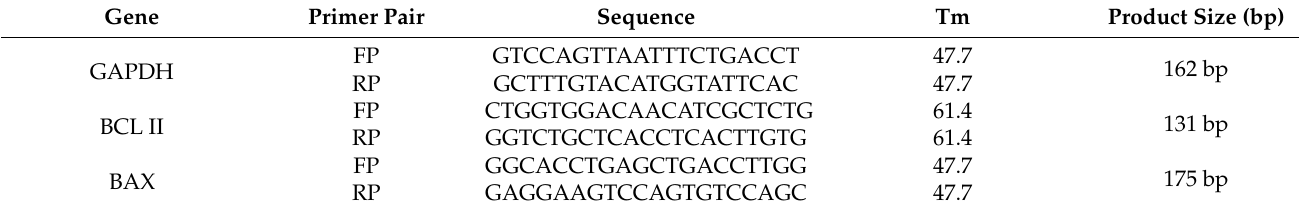
Table 1. Details of primer with the sequence and product size.